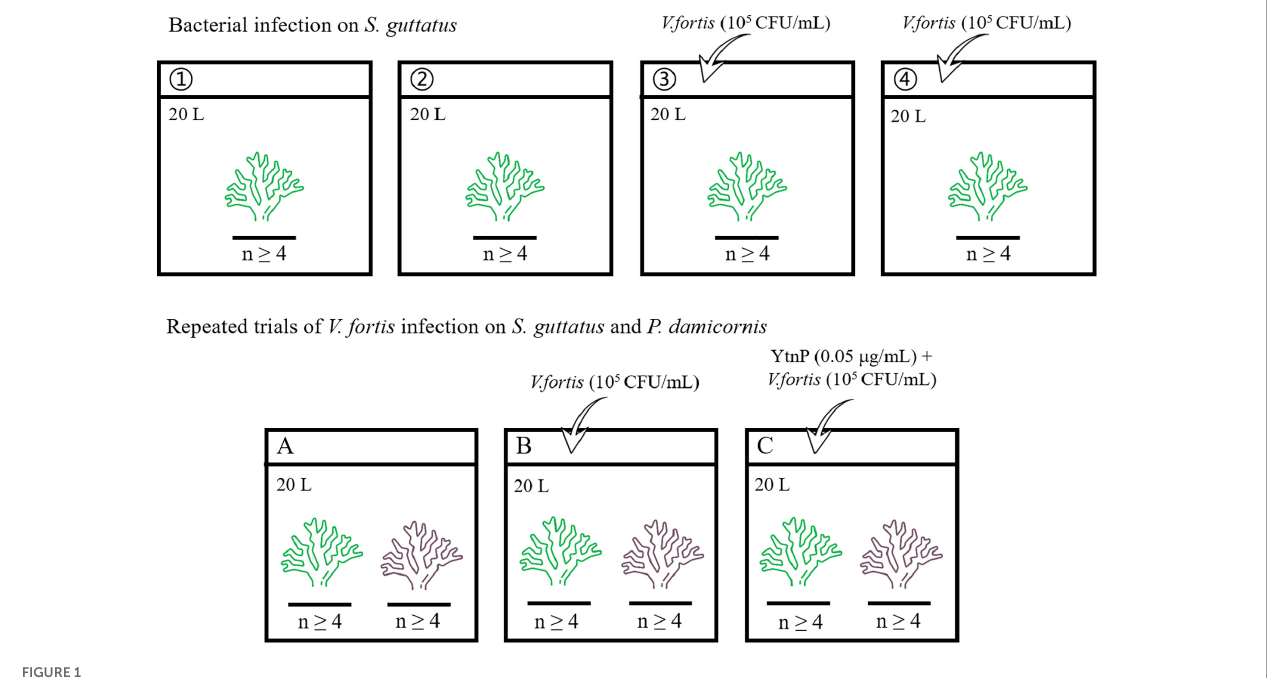
FIGURE1 Flowchart showing the experiment